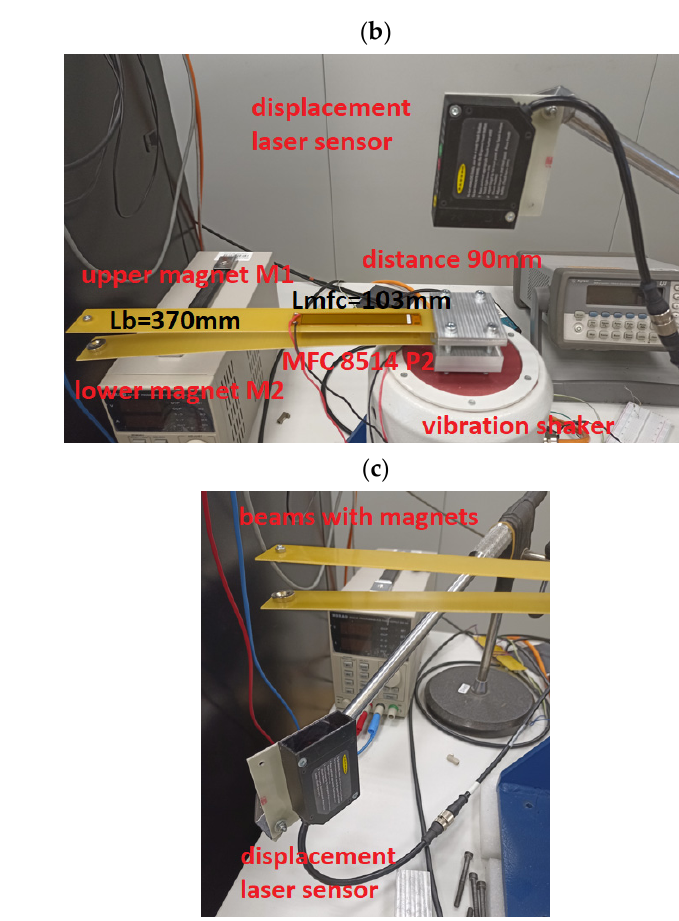
Figure 9. The view of a test rig during a lab test ( a ) the view of whole lab stand, ( b ) the view of lab stand with displacement laser sensor to measure a base vibration, ( c ) the view of lab stand with displacement laser sensor to measure the lower beam vibration.